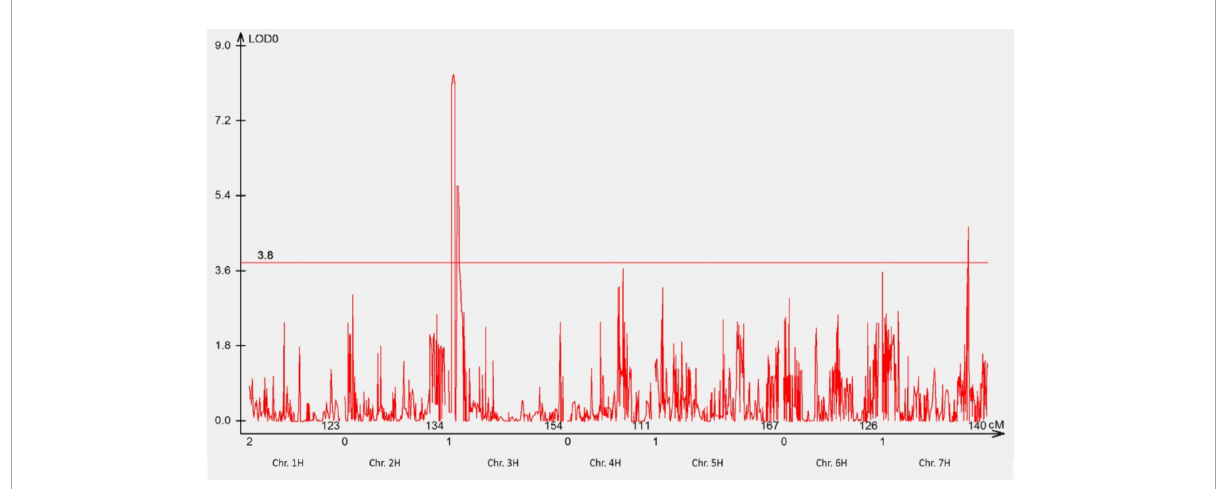
FIGURE5 Manhattan plot showing the most significant QTL conferring resistance to pathotype 5477 P– using genotypic data of DArTseq silico markers. Two QTLs were detected, one QTL was located on the distal region of the short arm of chromosome 3H, and another one was located on the long arm of chromosome 7H. The threshold value was set at